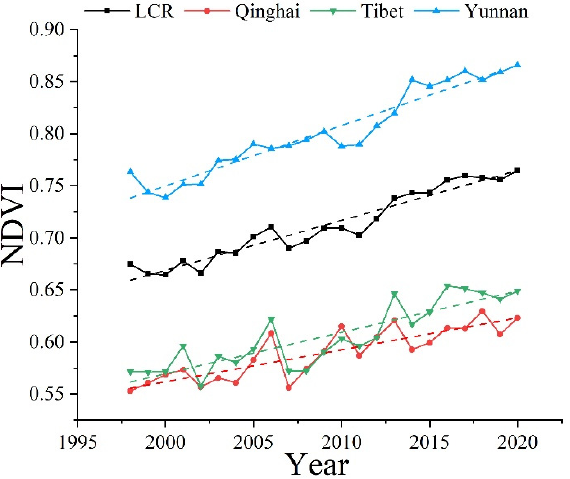
Figure 2. Change trend of NDVI in the Lancang River Basin from 1998 to 2020.